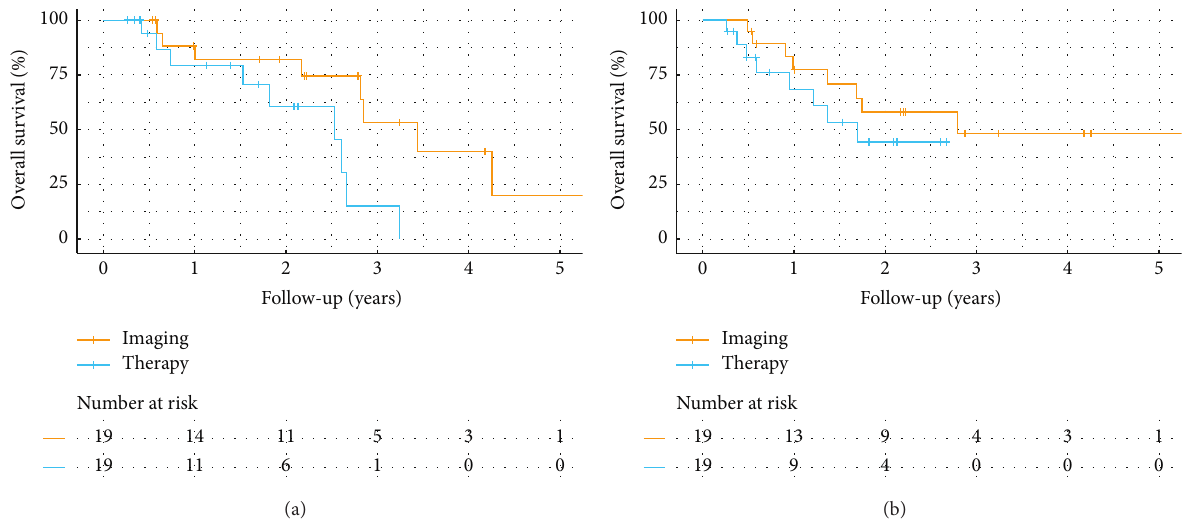
Figure 1: Kaplan–Meier plots. (a) Overall survival estimates (OS) (and patients at risk) from initial diagnosis/imaging and from initial chemosaturation therapy. (b) Estimates of progression-free survival (PFS) (and patients at risk) from initial diagnosis/imaging and from initial chemosaturation therapy.